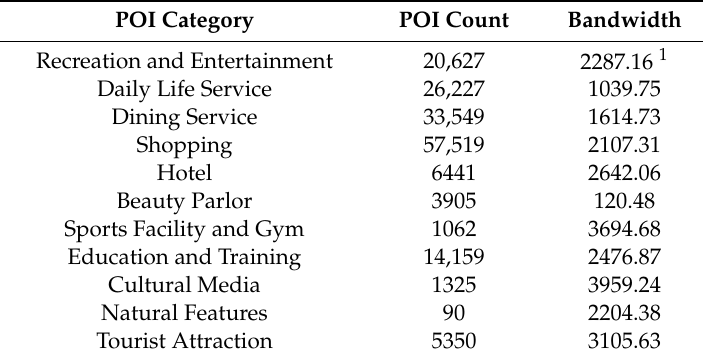
The count and the bandwidth of each category point of interest (POI) in kernel density